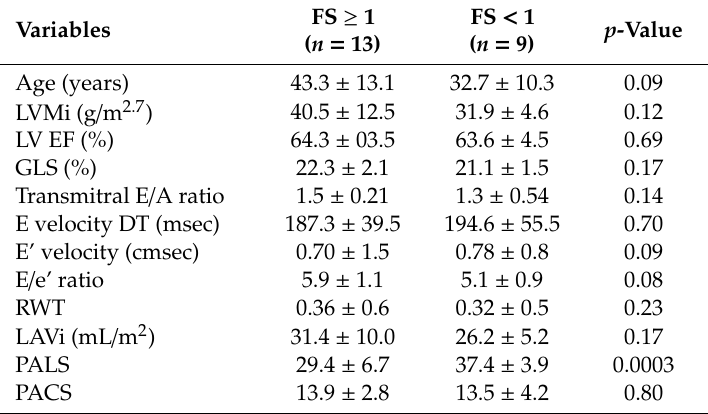
Figure 3. Reduction of PALS: upper left corner: two-dimensional echocardiography apical 2-chamber view, bottom left corner: color rendering of LA strain variation during cardiac cycle, right side: LA strain curves ( a ) and parallel axial FLAIR MRI image ( b ) showing multiple white matter hyper intensities lesions (arrows) in AFD patient. Fazekas score is = 1. Legend: PALS = peak atrial longitudinal strain; LA = left atrium; FLAIR = fluid attenuated inversion recovery; MRI = magnetic resonance imaging; AFD = Anderson-Fabry disease. Table 3. Echocardiographic measurements according to FS in AFD